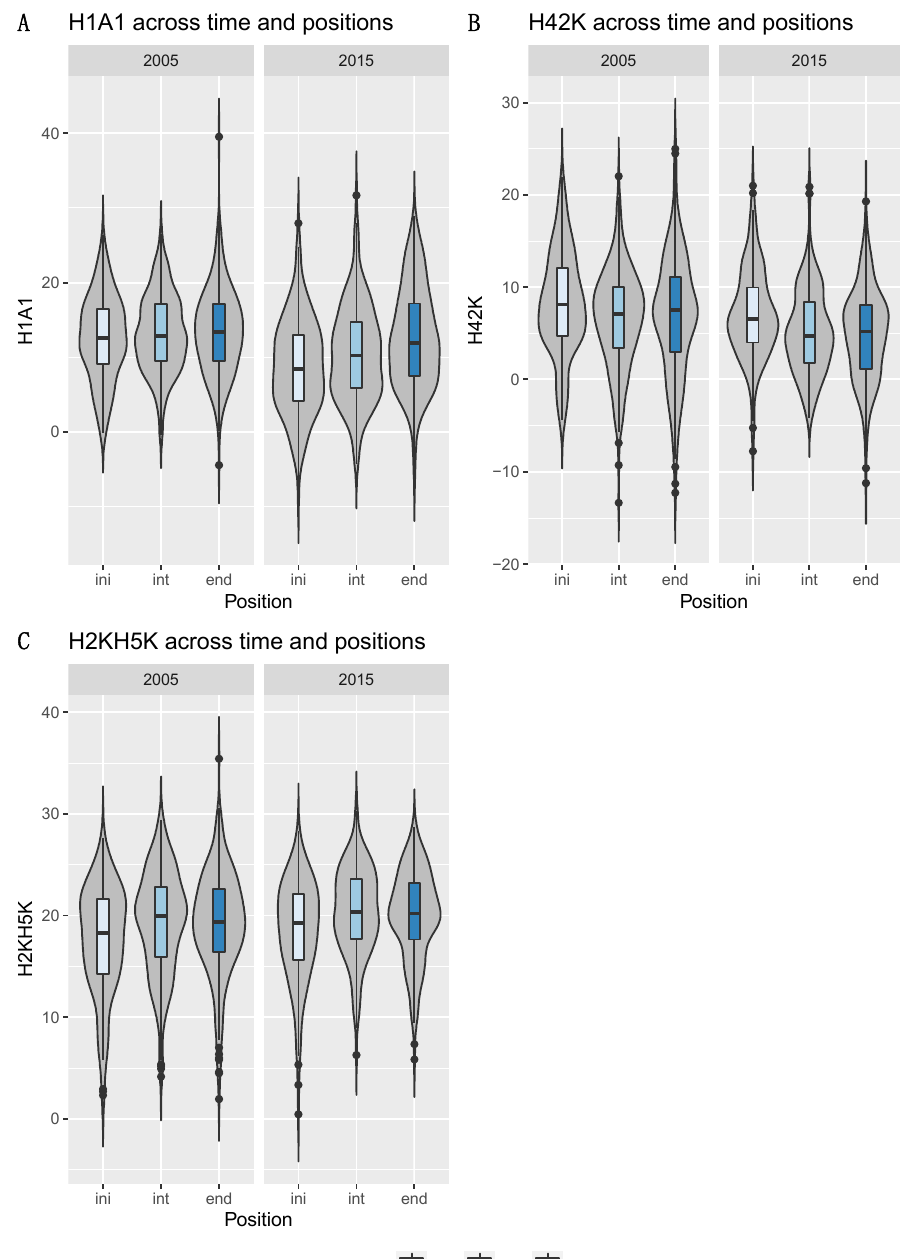
Figure 2. Violin plots showing rotated kernel density and boxplots with median values (black horizontal line) for spectral tilt parameters (( A ): H1A1, ( B ): H42K, ( C ): H2KH5K). Data are split by TIME of recording (2005 and 2015) and POSITION (initial, internal, end) of the filler particle.